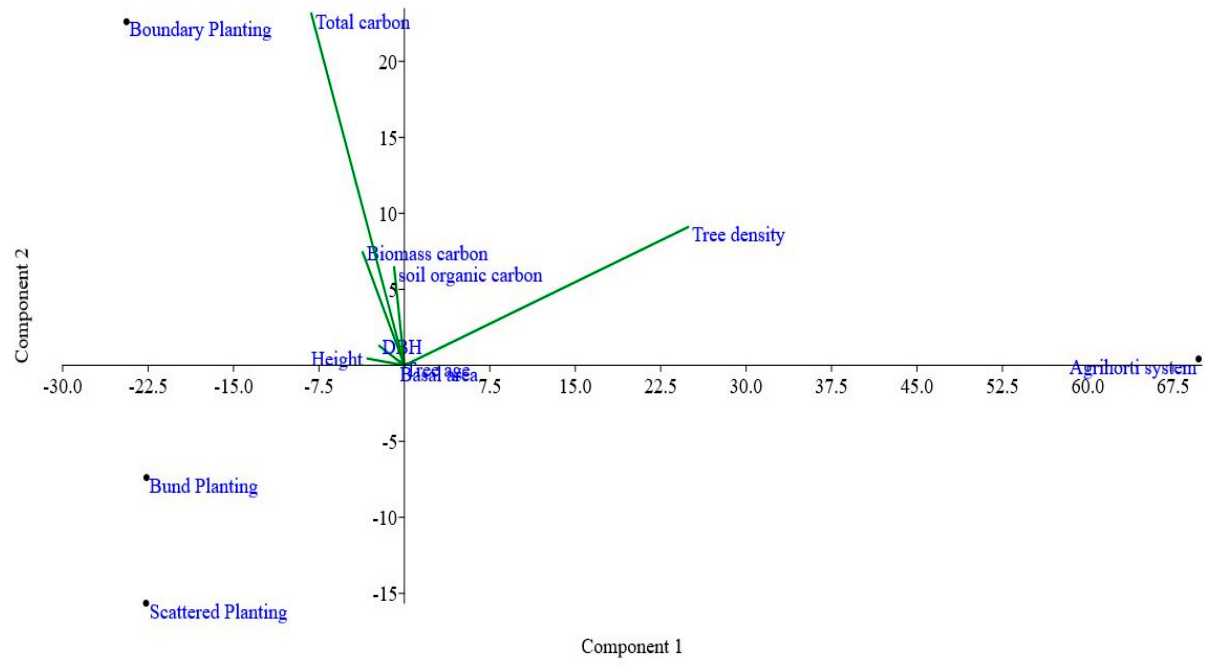
Figure 4. Principal component analysis (PCA) showing the relationship between tree carbon stocks and tree characteristics of different agroforestry systems in a semi-arid region. Table 6. Total Biomass+ Soil (ecosystem) carbon stock of different agroforestry systems under the semi-arid region.